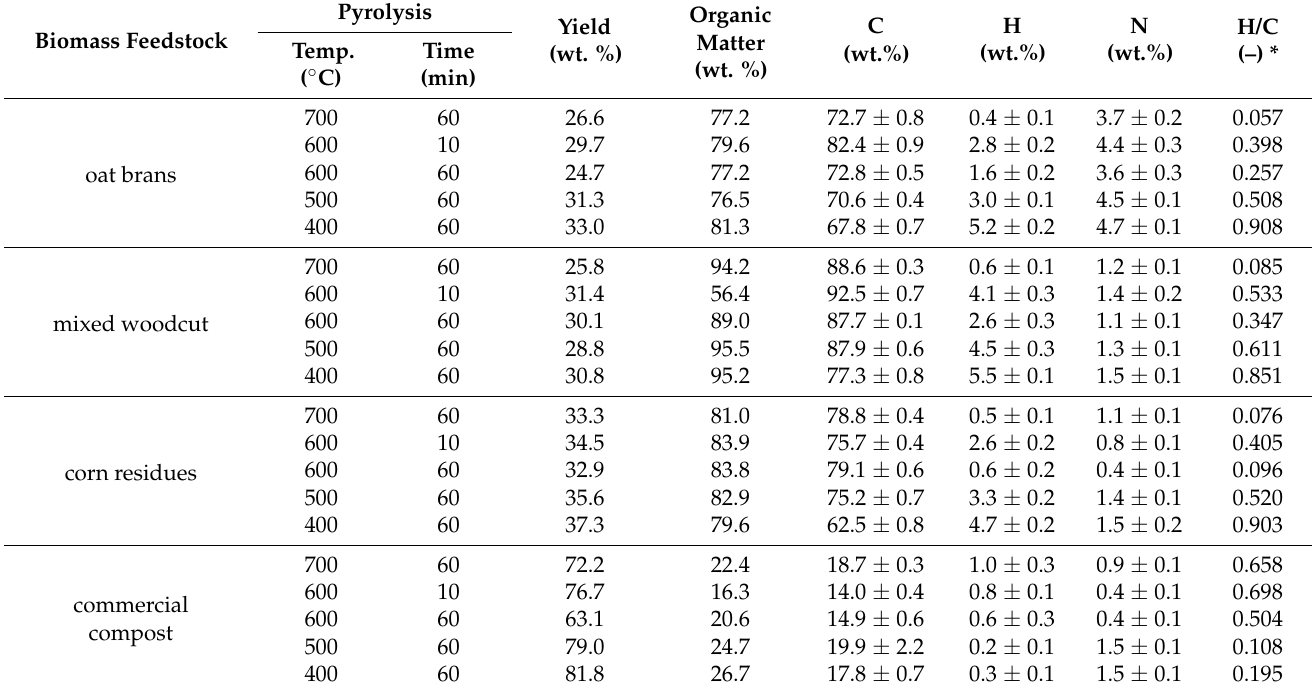
Table 1. Summary of yields of individual prepared biochar samples, their content of organic matter (determined by TGA) and organic elements (determined by